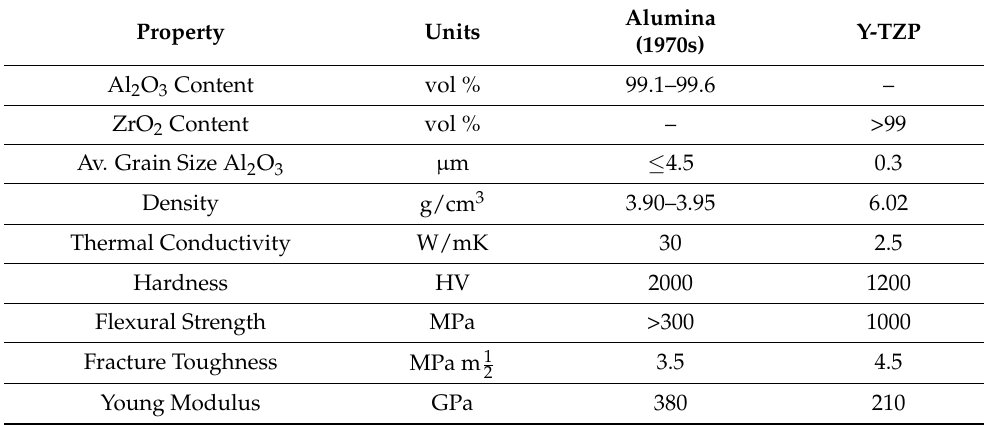
Table 2. Selected properties of Y-TZP. Alumina data reported for